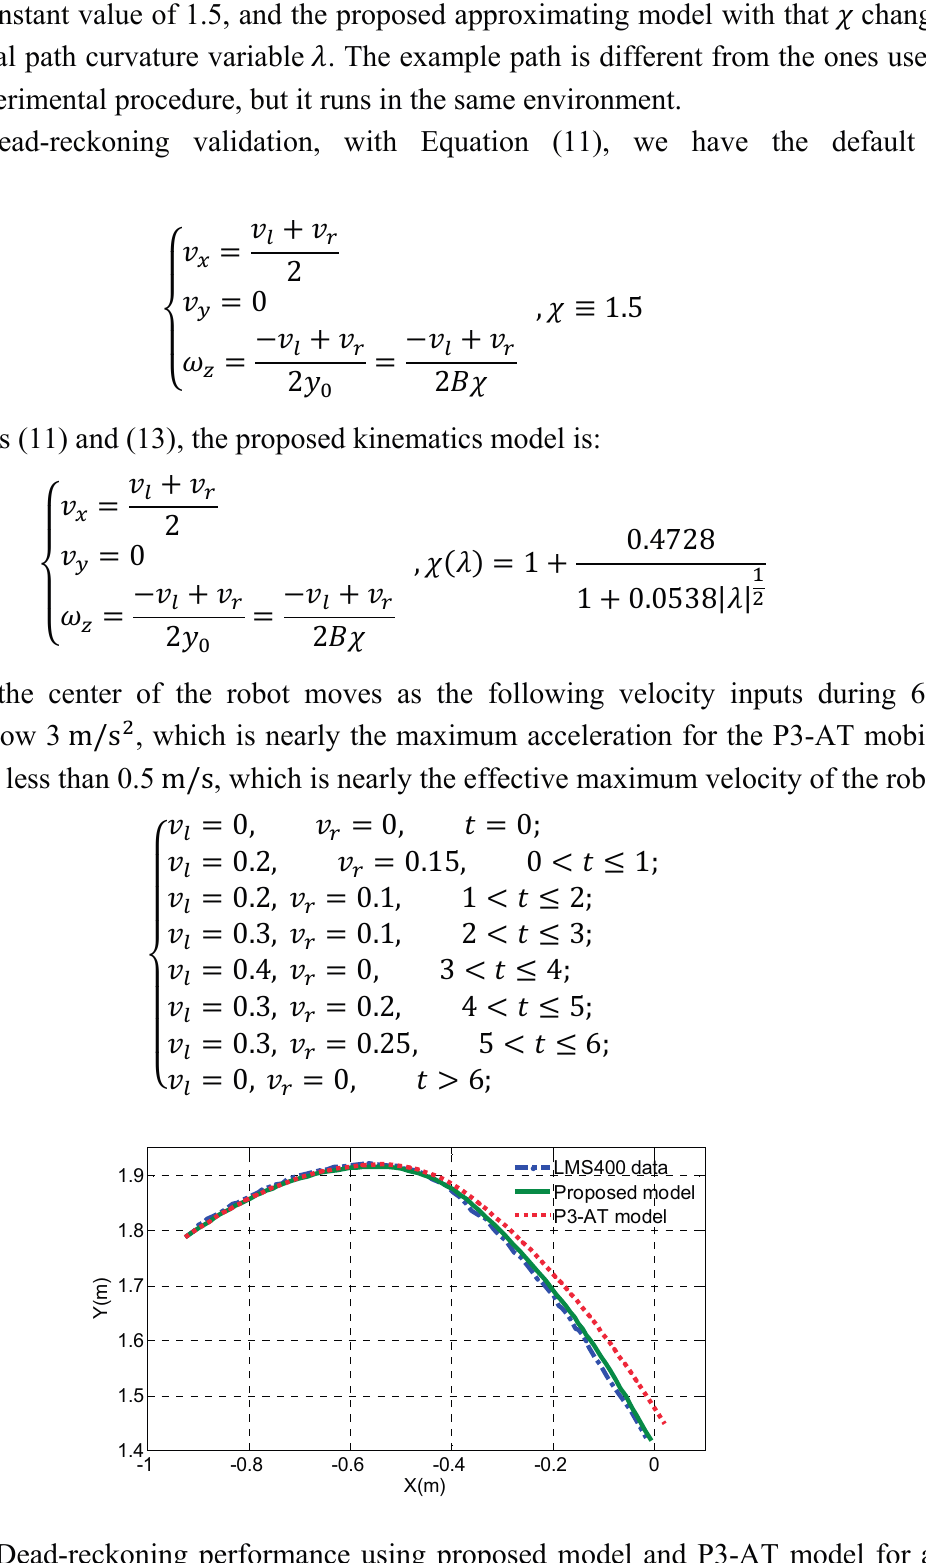
Figure 14. Dead-reckoning performance using proposed model and P3-AT model for an example path with the mobile